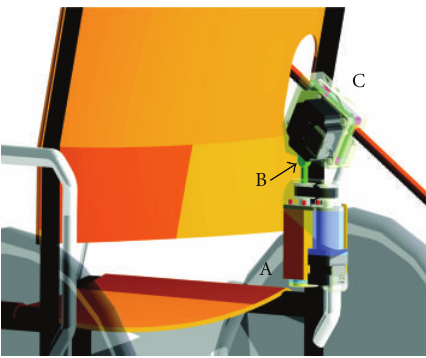
Figure 4: Shoulder supports structure mounted on the wheelchair A: vertical axle, B: passive joint, C: linear